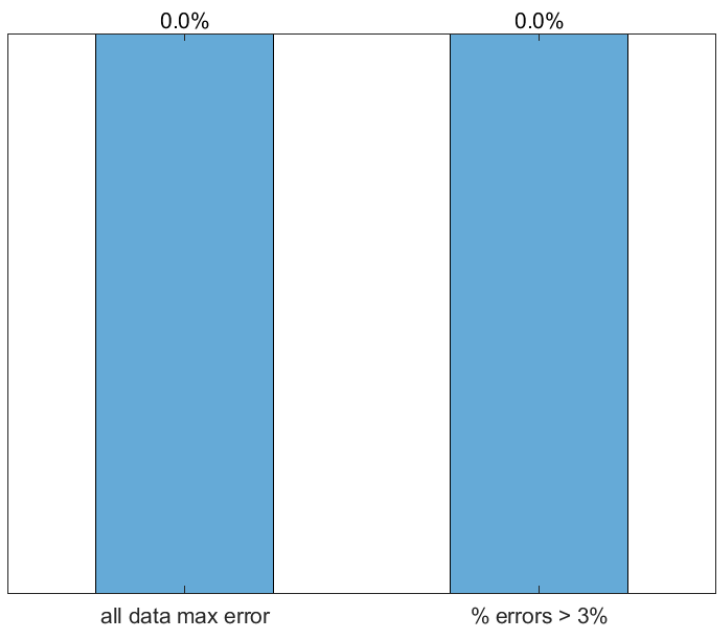
Figure 7. Maximum error of all datapoints and percentage of datapoints with an error larger than 3%.